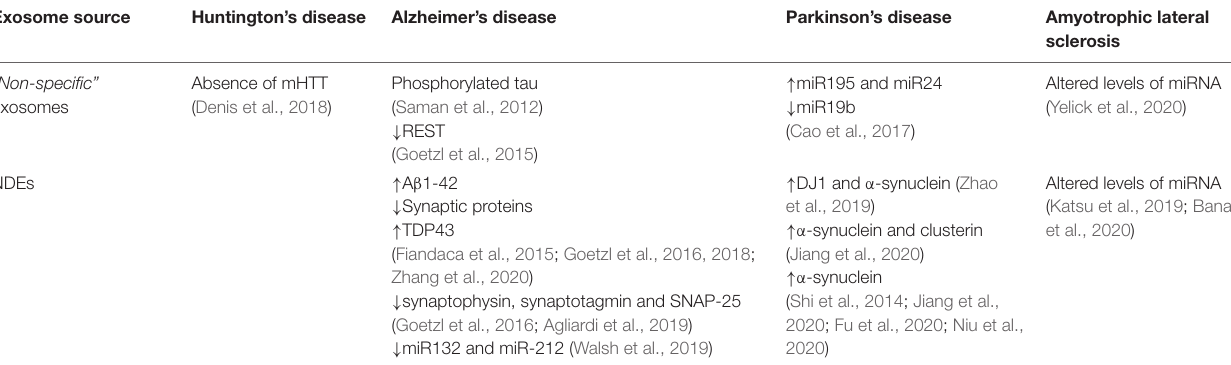
TABLE 1 | Candidate biomarkers for neurodegenerative disorders transported in exosomes from different human